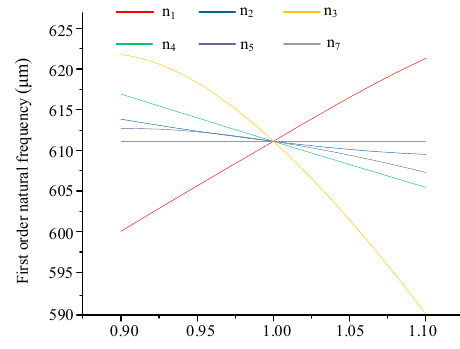
Figure 28. Frequency response curve.